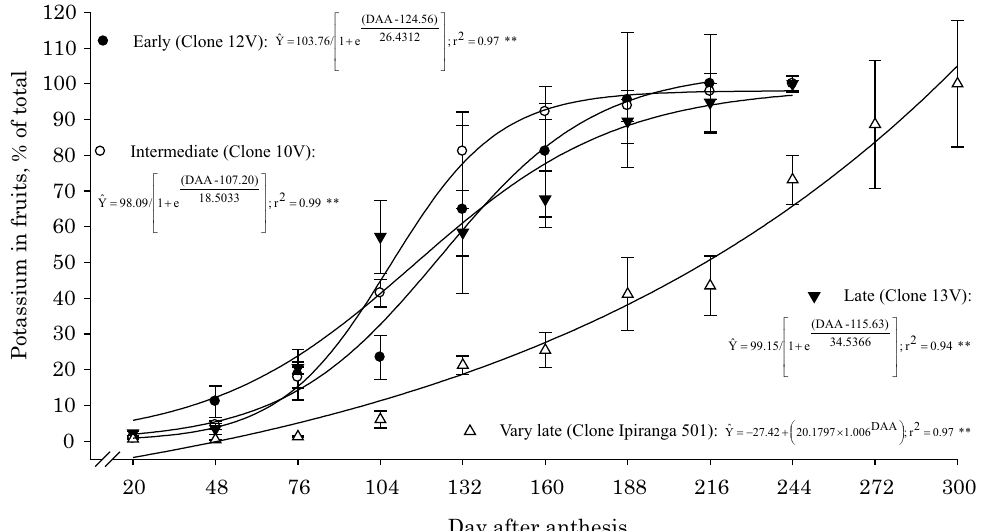
Figure 4. Accumulation of potassium in fruits (in percentage of the cumulative total) of four genotypes (clones) of Conilon coffee, from anthesis to fruit maturation. The bars refer to the standard error of the average. ** significant at 1 % probability.